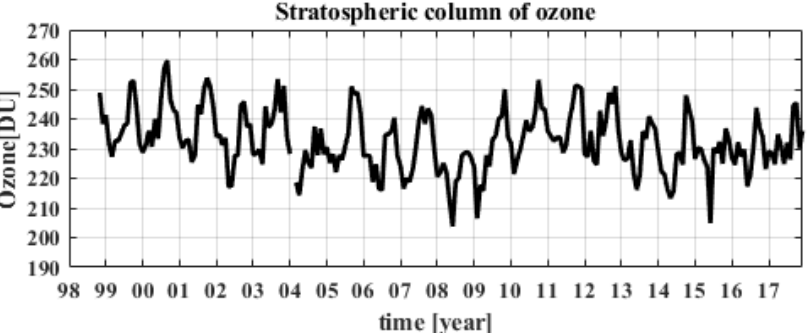
Figure 7. Time-evolution of stratospheric partial column of ozone obtained by subtracting the tropospheric column of ozone from the total column of ozone.